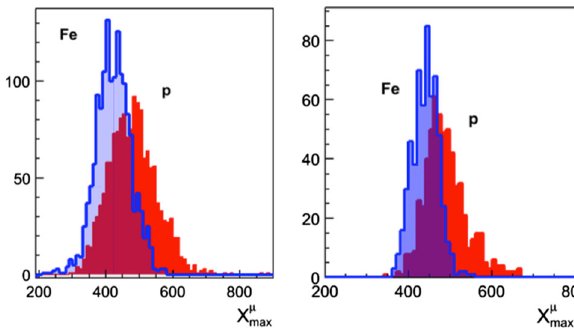
μ Fig. 11 X max distributions for simulated showers initiated by protons and iron at θ = 38 ◦ with E = 10 19 eV (left) and E = 10 19 . 8 eV (right) obtained with